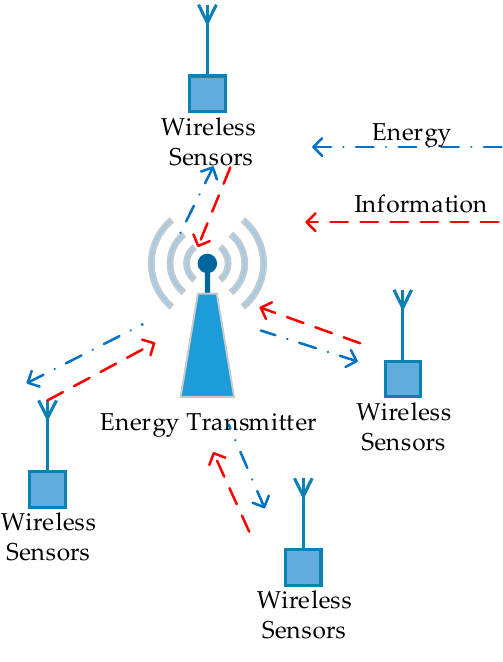
Figure 1. System model for a WPSN.